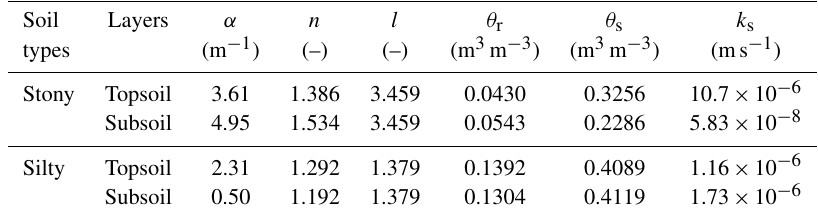
Table D1. Soil physical parameters in the topsoil (0–30cm) and subsoil (30–150cm).